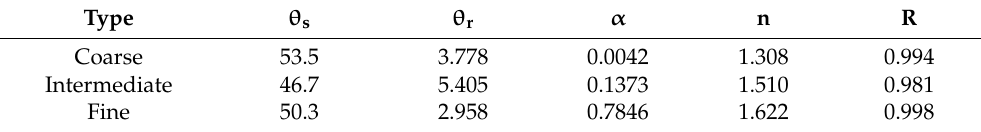
Table 1. Mean fitted values and coefficients of determination (R). Model of Van